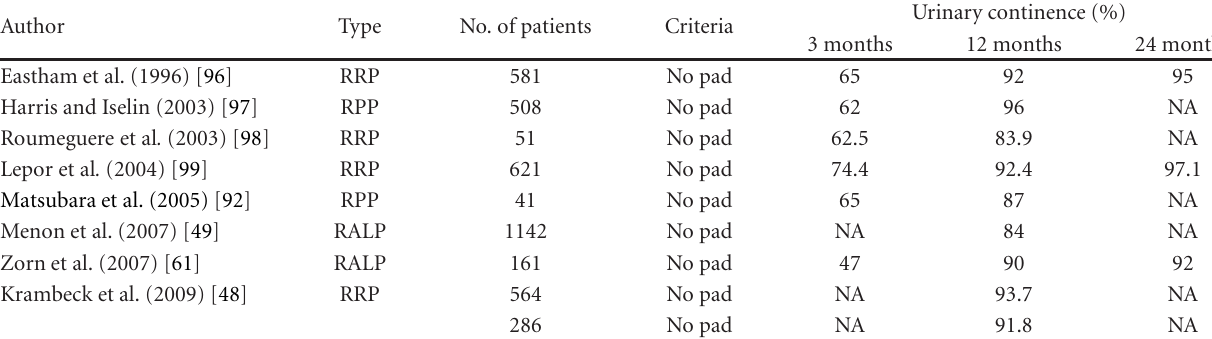
Table 4: Recovery of continence rates following RRP, RPP, and RALP.